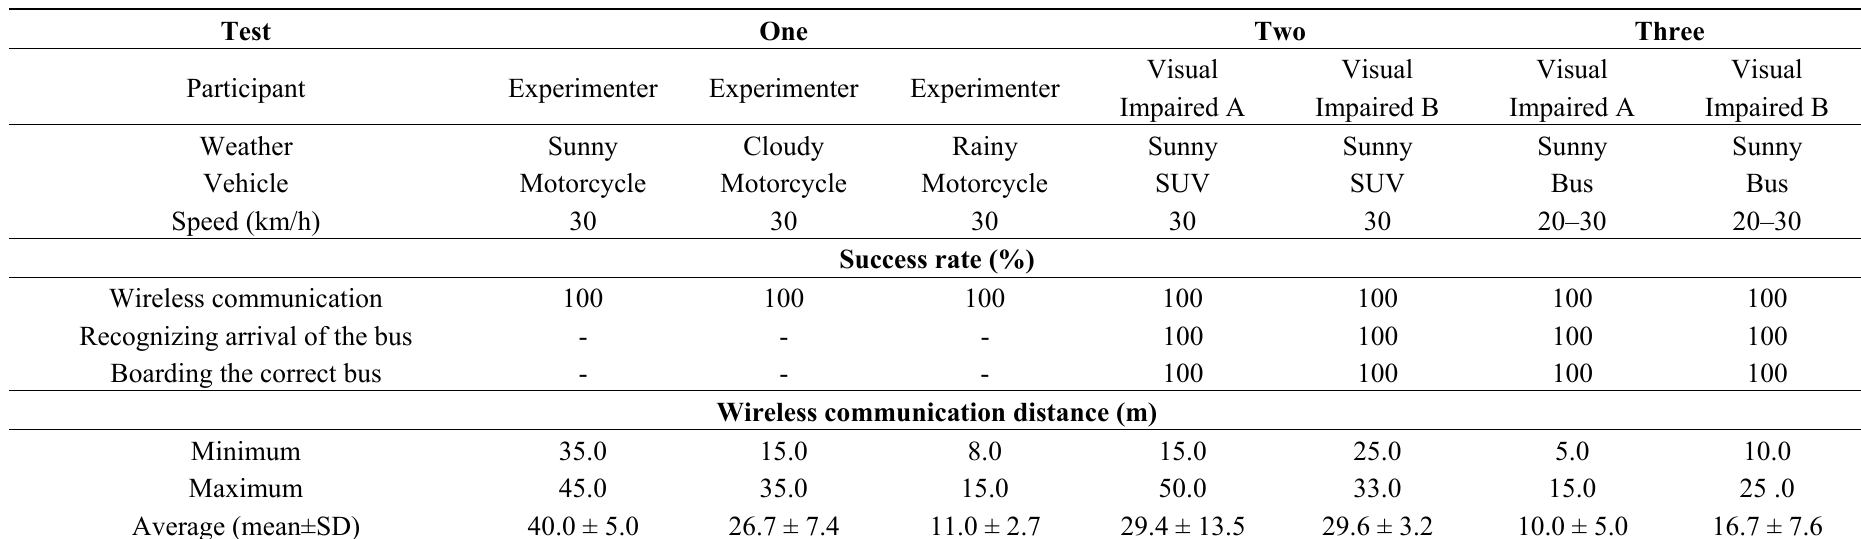
Table 1. Results of Test 1 to Test